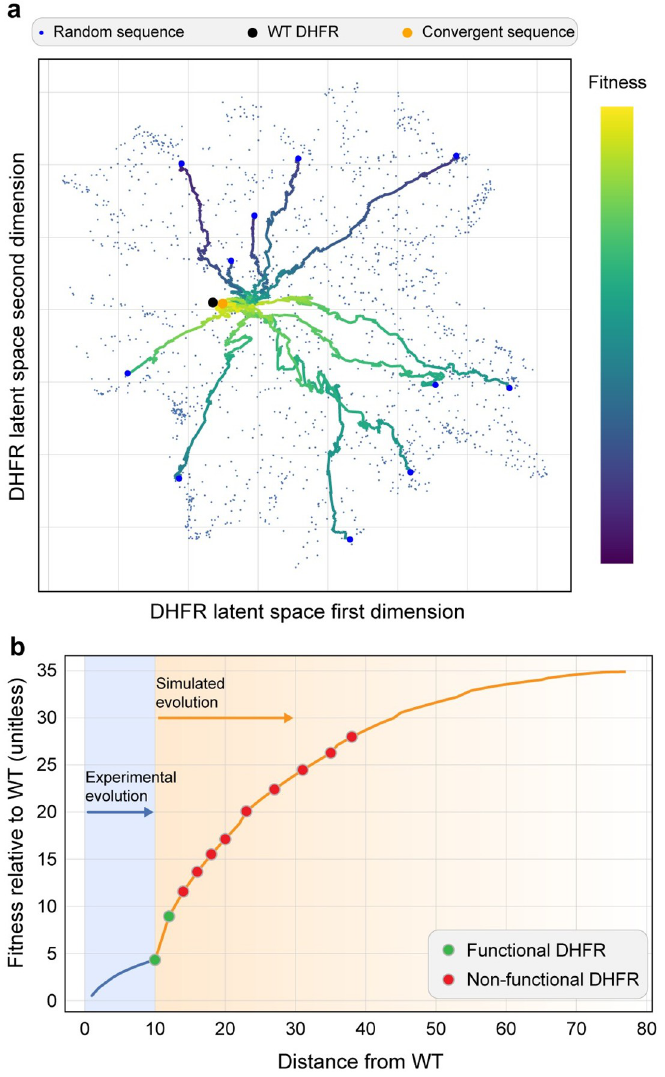
Fig 3. Evolutionary simulations to understand the landscape structure. (a) We uniformly sampled random amino acid sequences of length 186 and performed an adaptive walk until a fitness peak was reached. All adaptive walks converged to the same fitness peak. 11 representative evolutionary trajectories are shown. (b) We continued our laboratory DHFR evolution by continuing the evolutionary process in silico . We experimentally tested several DHFR sequences along the evolutionary trajectory and found many were inactive